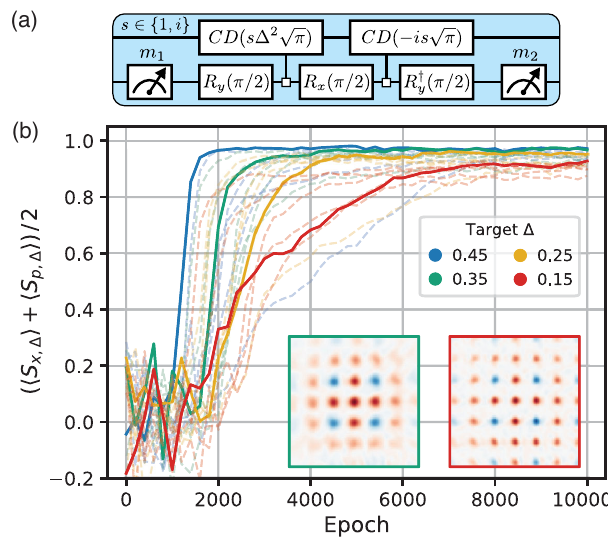
FIG. 3. Preparation of grid states. (a) Stabilizer reward circuit for the target state j ψ GKP Δ i . The circuit makes use of the condi- α = 2 Þ . The control circuit tional displacement gate CD ð α Þ ¼ D ð σ z is the same as in Fig. 2(a). (b) Evaluation of the training progress. The background trajectories correspond to six random seeds for each state; solid lines show the trajectory with the highest final stabilizer value. Inset: example Wigner functions of the states prepared by the agent after 10,000 epochs of